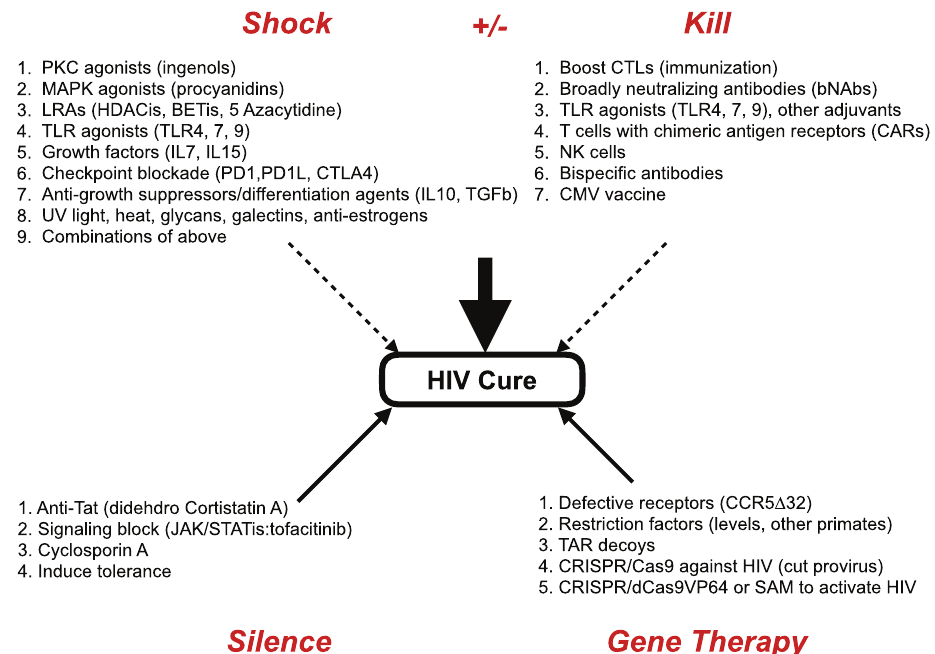
Figure 1. Four main approaches that target the latent reservoir of HIV. Four research areas, which reactivate HIV (1. shock), eliminate HIV (2. kill), silence HIV (3. silence), or alter the immune system to resist HIV (4. gene therapy) should contribute to the functional or complete cure of HIV in infected individuals. Within each area are individual components of that therapy. They can be applied individually or in combinations, which should decrease their doses and deleterious effects. Most likely, there will be additional approaches in the